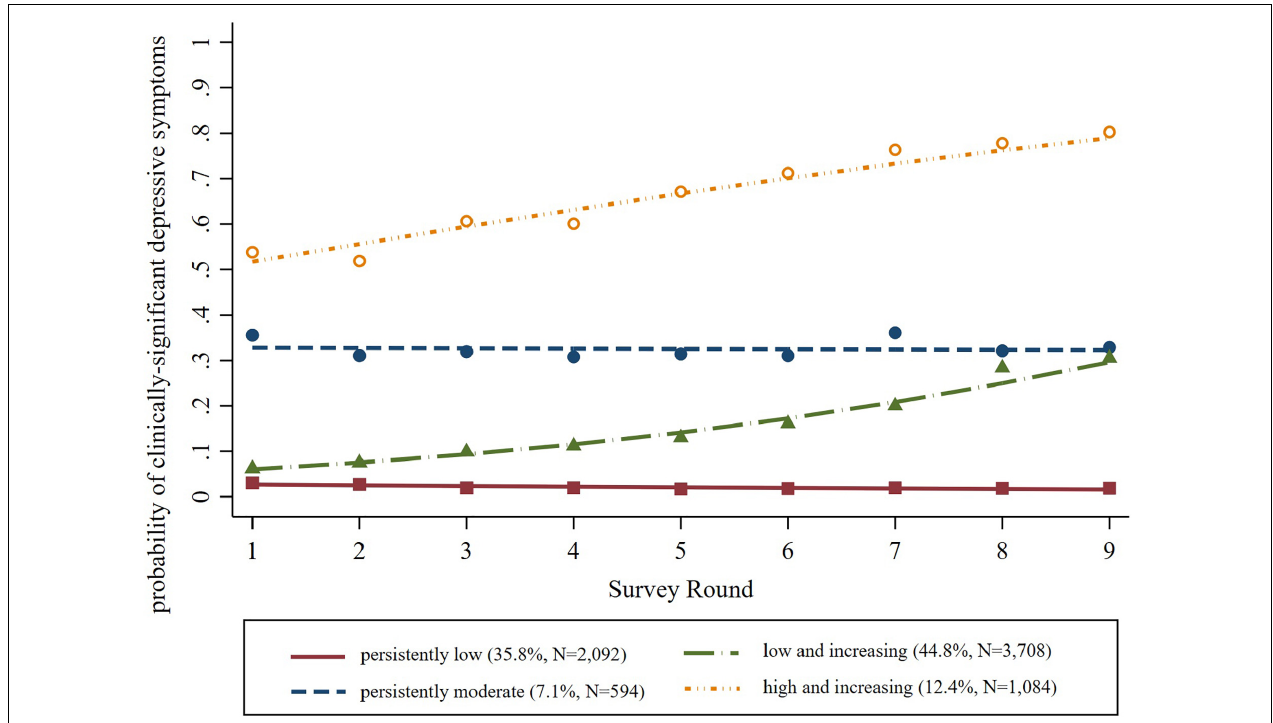
FIGURE 2 | Probability of clinically significant depressive symptoms by trajectory